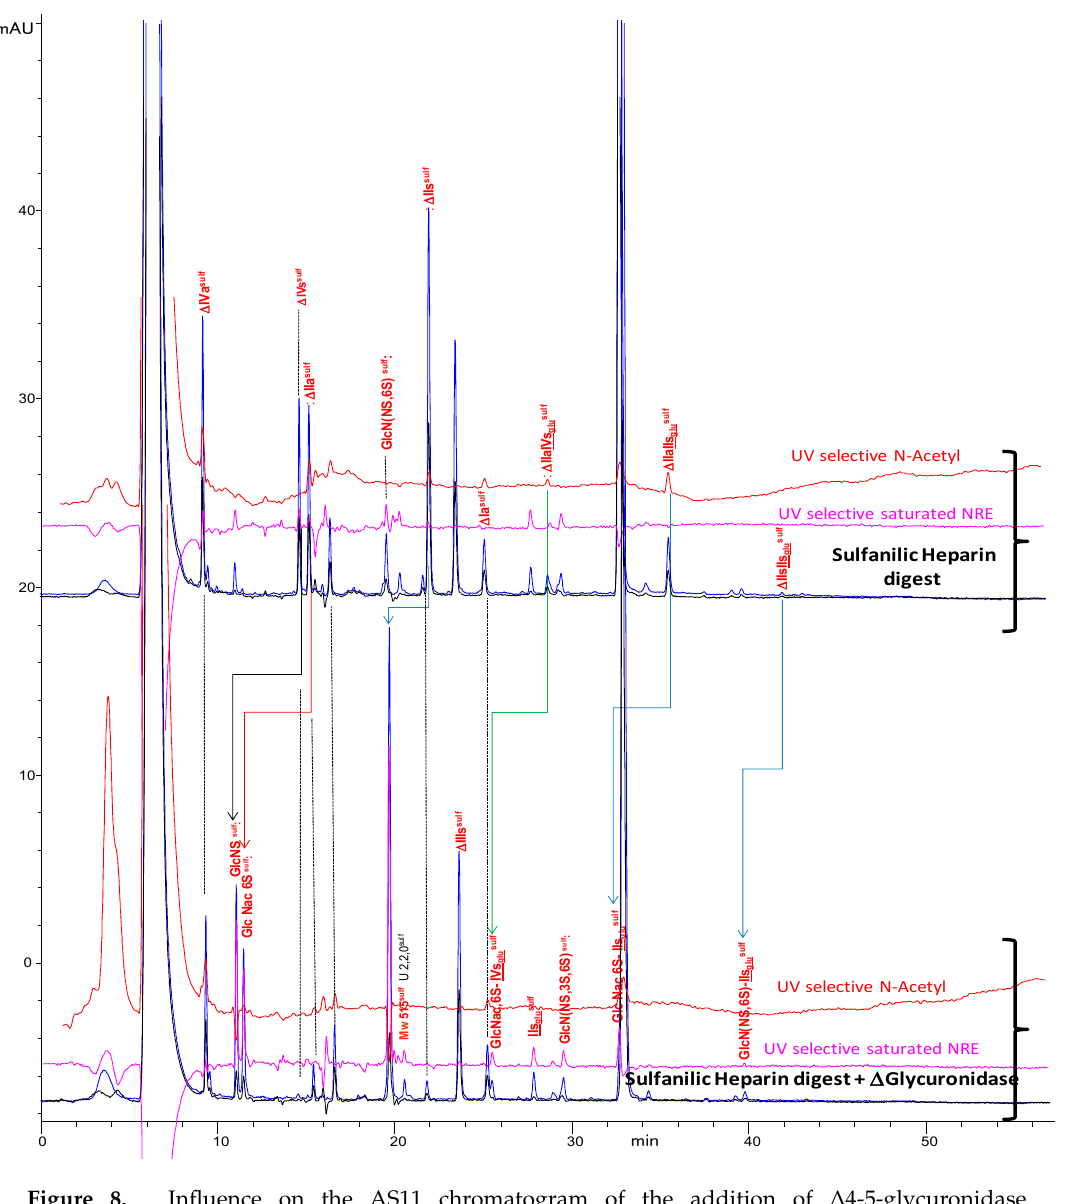
Figure 8. Influence on the AS11 chromatogram of the addition of Δ 4-5-glycuronidase of the heparinase sulfanilic digest of heparin. Detection: — 232 nm; — 265 nm; — 200 nm − 1.28 × 265 nm; — 265 nm − 2.2 × 232 nm Peak assignment : IIs glusulf : GlcA-GlcN(NS,3S,6S)-SA, Is idsulf : IdoA(2S)-